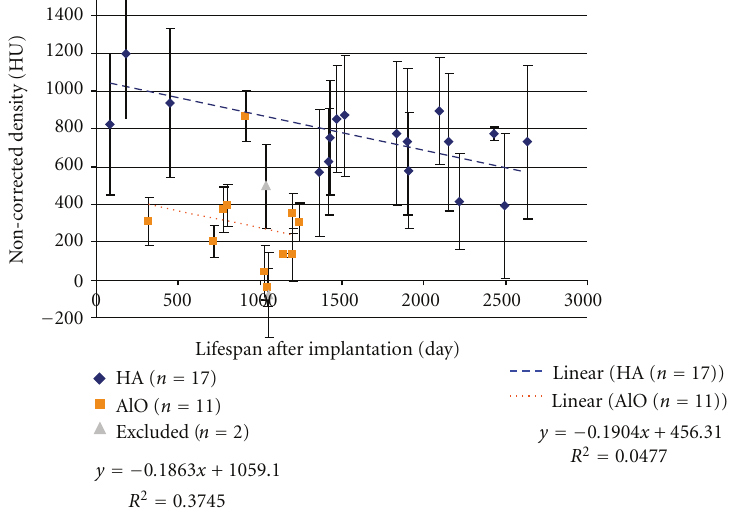
Figure 9: Scatter plot of the time between implantation and the HU (density). Conventionally noncalibrated and noncorrected plots. Linear regression was applied to both implants separately. The excluded ( n = 2) cases are also